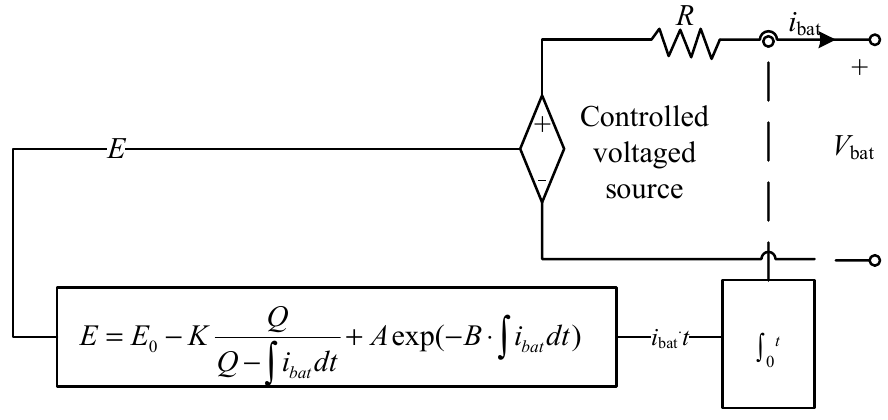
Figure 2. The equivalent model for LiB.